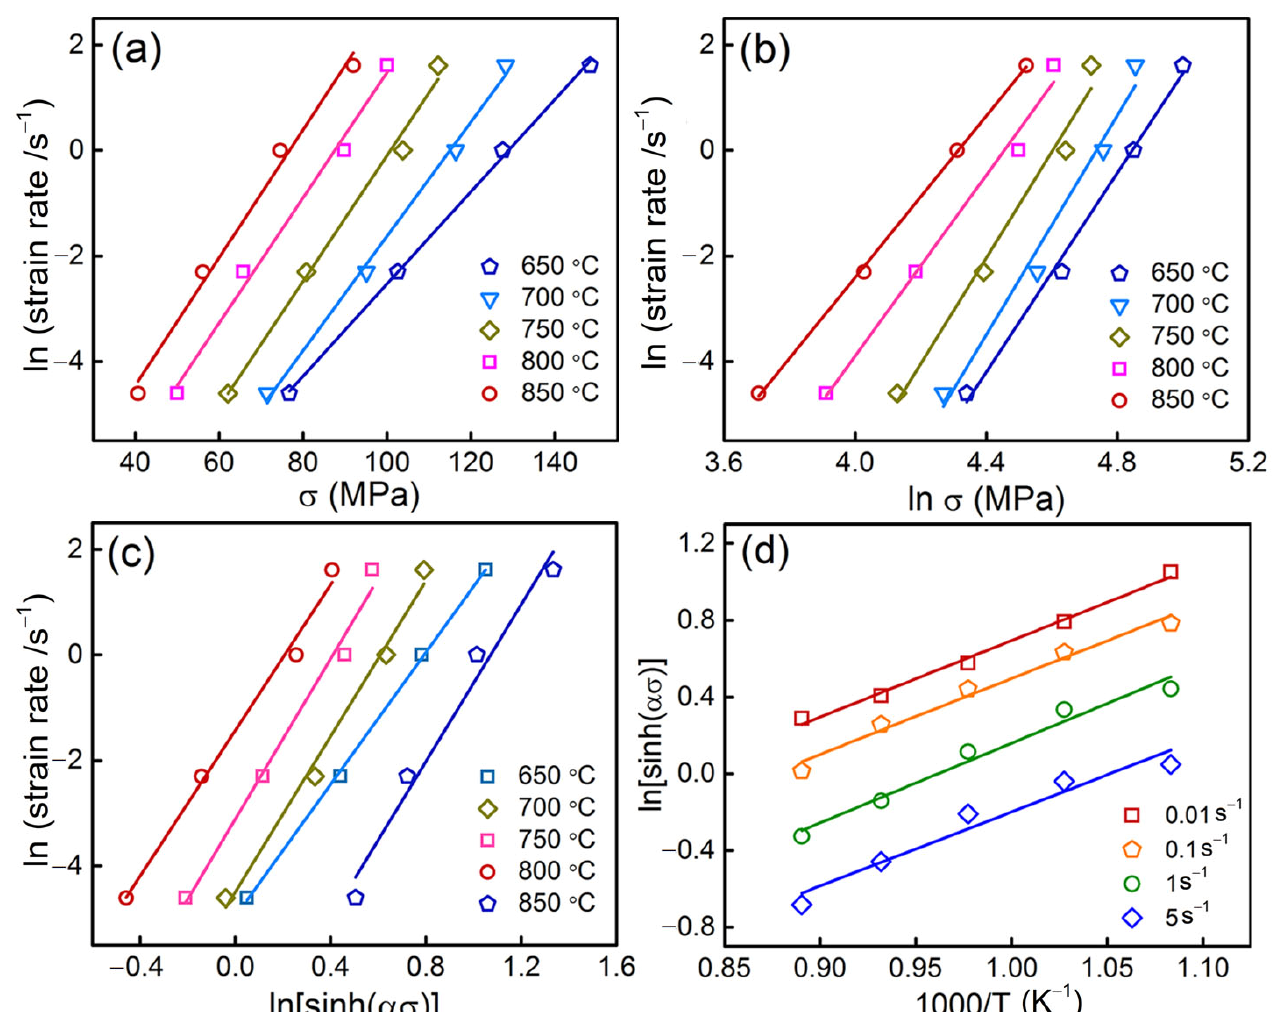
. . . ε − σ ; ( b ) ln ε − ln σ ; ( c ) ln ε − lnsinh ( ασ ) , and ( d ) ln